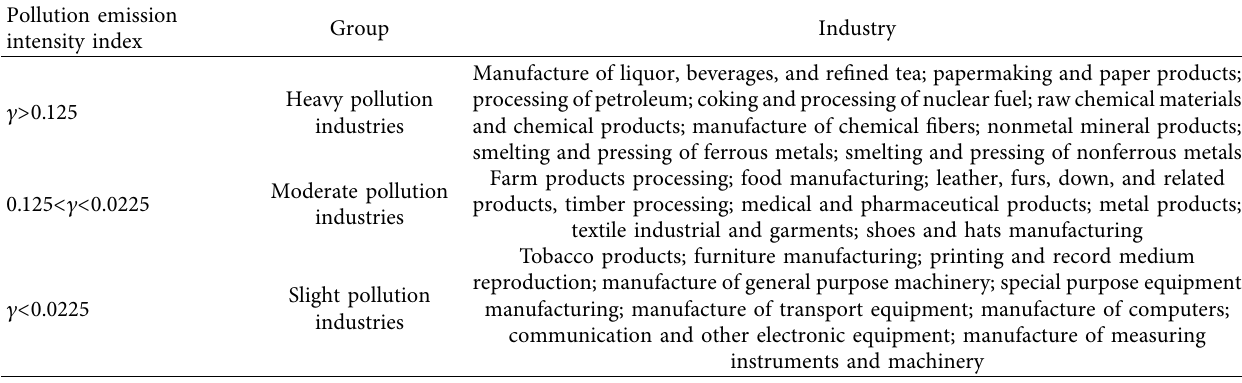
Table 1: Industry classifications based on pollution emission